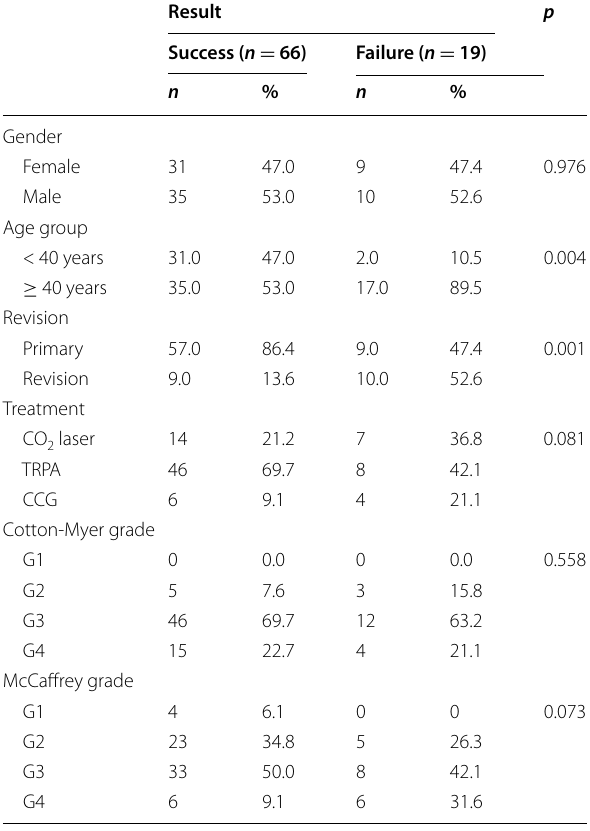
Table 3 Distribution of patients according to surgical results